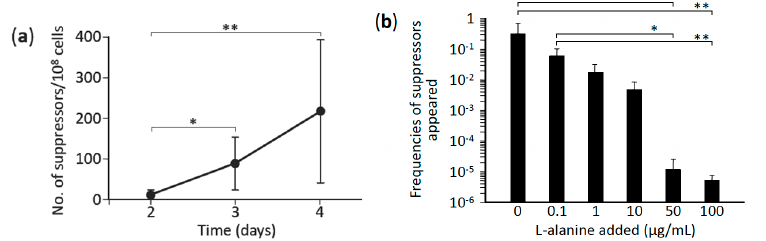
Figure 1. Effect of incubation time and L-alanine concentration on the appearance of L-alanine prototrophic suppressors. L-alanine auxotroph HYE032 cells were seeded on minimal agar medium without L-alanine supplementation and incubated at 37 °C for 2–4 days. ( a ) Colonies that newly appeared on each day were counted and the frequency of suppressors per 10 8 cells inoculated was calculated. Points represent means and standard deviation from >3 independent experiments. ( b ) HYE032 cells were inoculated into a minimal liquid medium containing various con- centrations of L-alanine (0.1–100 μ g/mL) and incubated to late-log phase, and the frequency at which suppressors appeared was evaluated. Data represent means and standard deviation from 3 independent experiments. Statistical analyses; ( a ) * p < 0.05, ** p < 0.0001 and ( b ) * p < 0.01, ** p < 0.001.